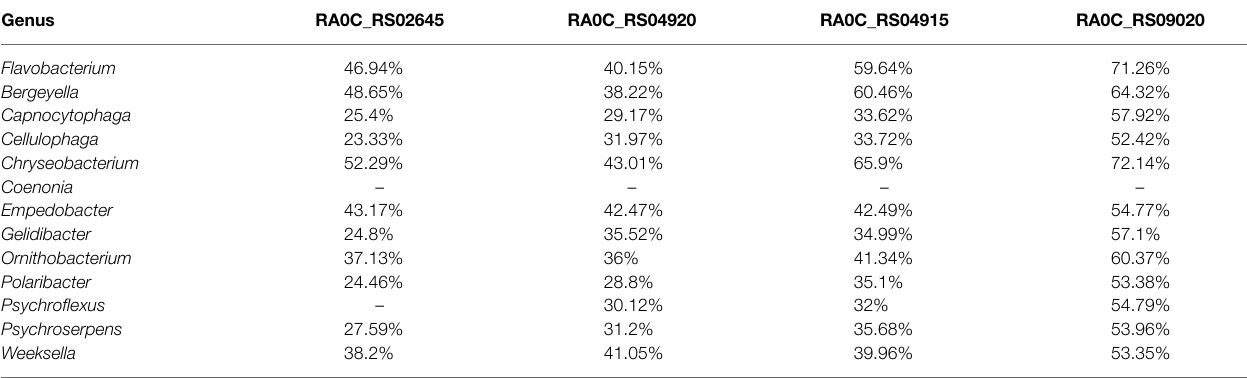
TABLE 4 | Distribution of RA0C_RS02645, RA0C_RS04920, RA0C_RS04915, and RA0C_RS09020 in Flavobacteriaceae.